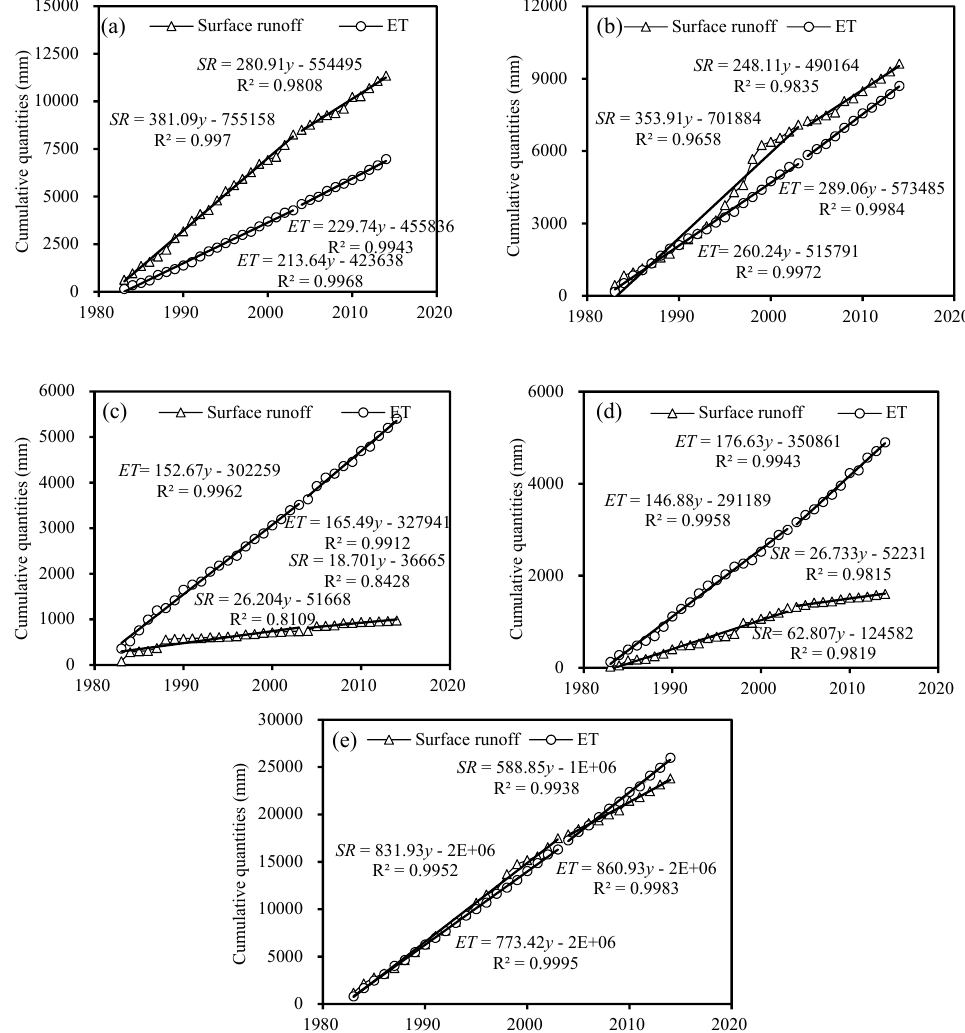
Figure 7. Relationships between year and cumulative surface runoff, ET in spring ( a ), summer ( b ),